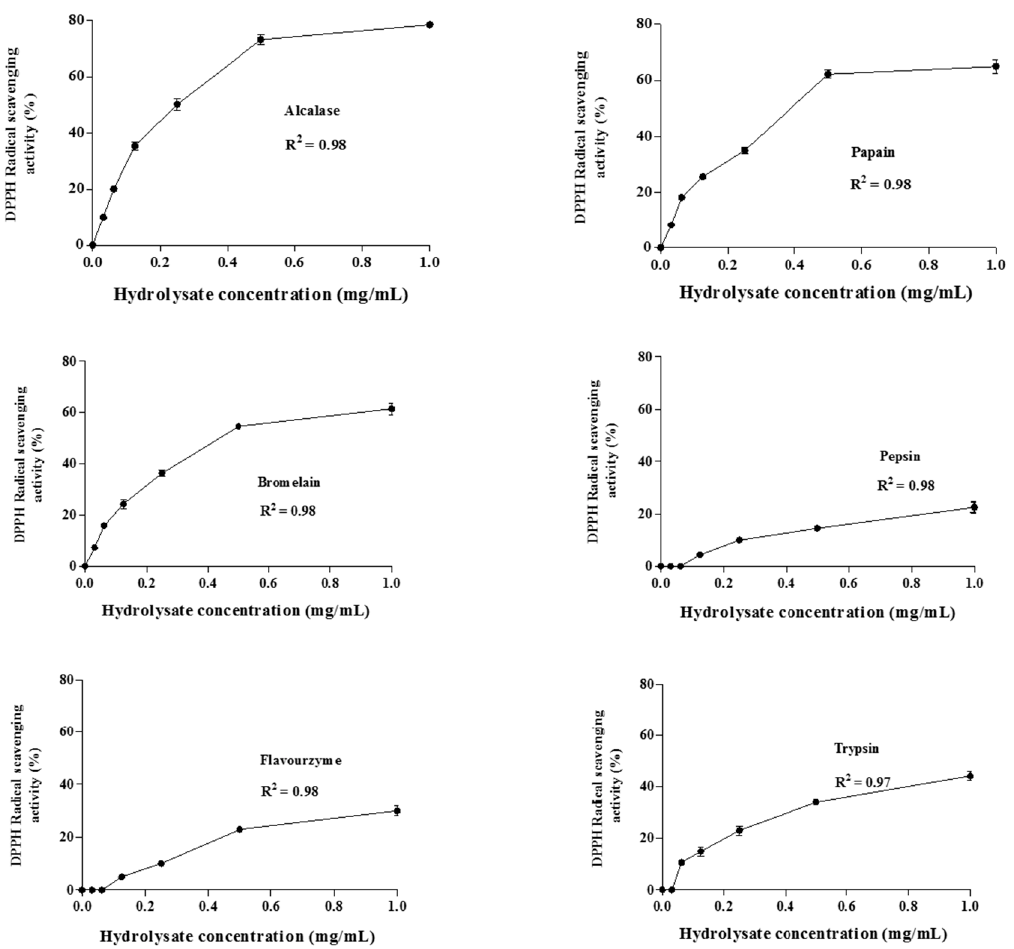
Figure 4. Changes in DPPH radical scavenging activities (%) of A. lecanora hydrolysates as a function of concentrations between 0.0 and 1.0 mg dry weight/mL. Each value is the mean ± SD of three replications.